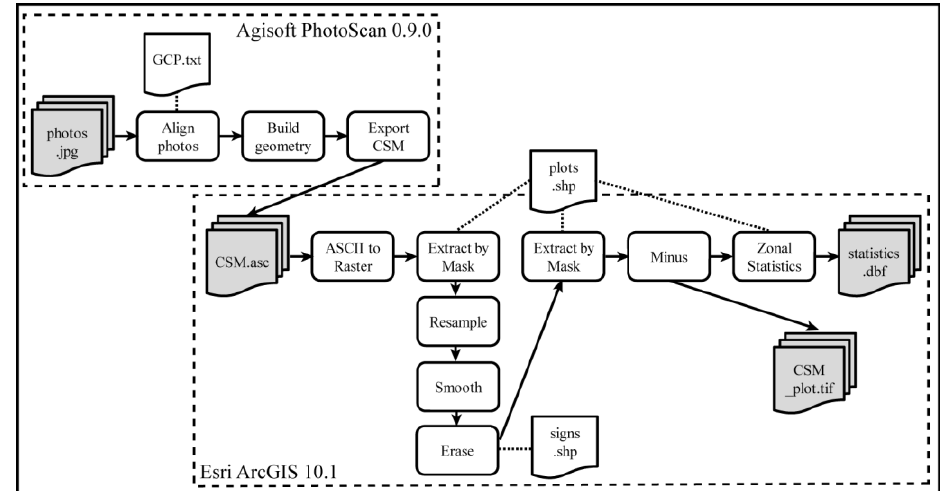
Figure 4. Data Processing workflow for generation of CSM (CSM.asc) from RGB images captured by UAV-system (photos.jpg) in Agisoft PhotoScan and further processing for analysis in Esri ArcGIS.